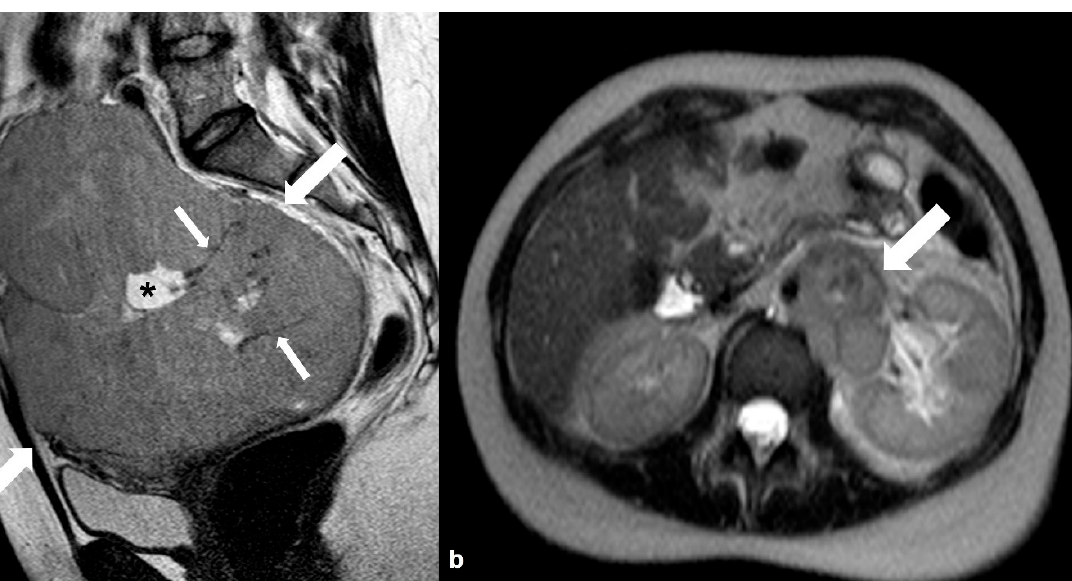
Figure 19. Dygerminoma. Axial T2 weighted image ( a ) shows a predominantly solid ovarian mass (large arrows) with thin low signal intensity internal septa (thin arrows) and cystic/necrotic area (asterisk). T2 weighted image ( b ) of the same patient at the level of the renal hilum shows multiple enlarged left paraaortic lymph nodes (arrow).